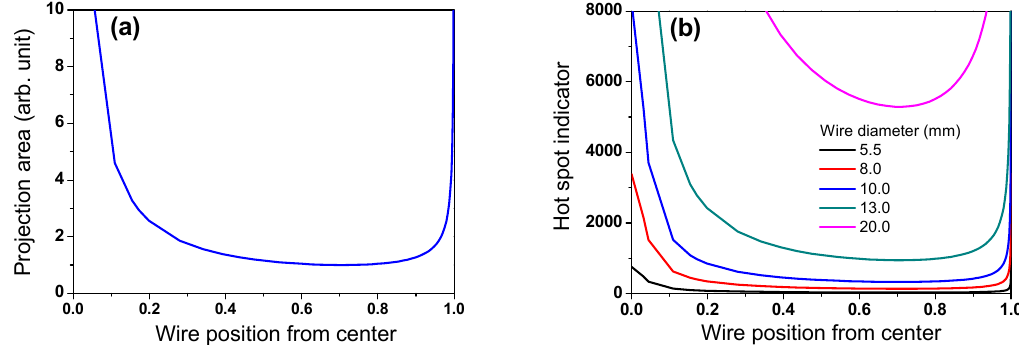
Figure 13. ( a , b ) Schematic of contact angle of wire ring and ( c ) calculated contact angle of wire ring along TD wr during Stelmor cooling.